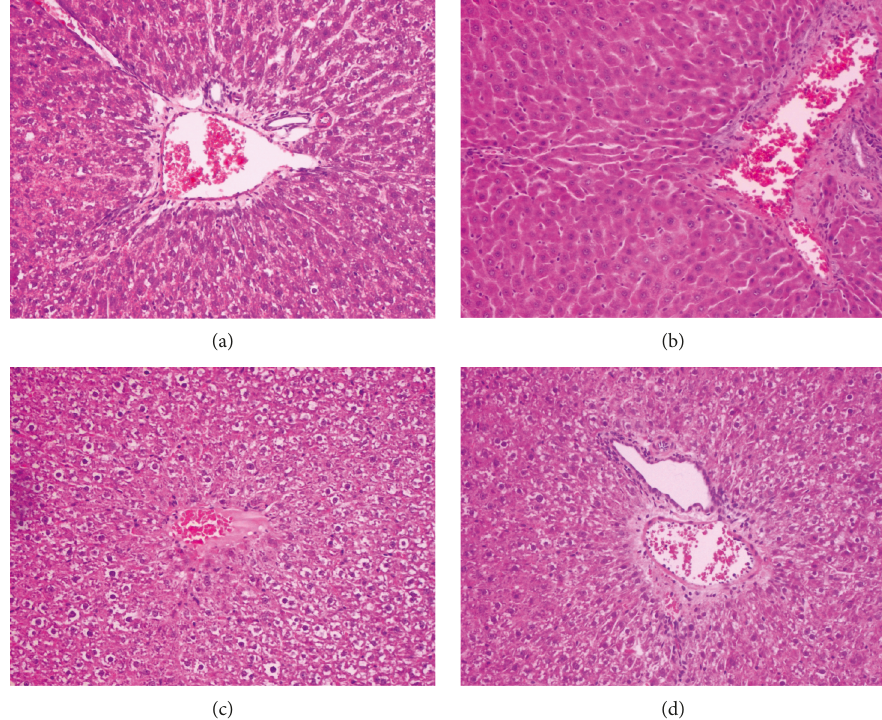
Figure 1: E ff ect of kynurenic acid (KYNA) on liver histology in thioacetamide (TAA) induced liver injury in rats. (a) Control group: normal cell structure and lobular architecture. (b) KYNA (500mg/kg) treated group: normal cell structure and lobular architecture. (c) TAA (150mg/ kg) treated group: signi fi cant hepatocellular damage with severe in fl ammatory cell in fi ltration. (d) KYNA (500mg/kg) and TAA (150mg/kg) treated group: mild in fl ammation. Hematoxylin and eosin staining, magni fi cation